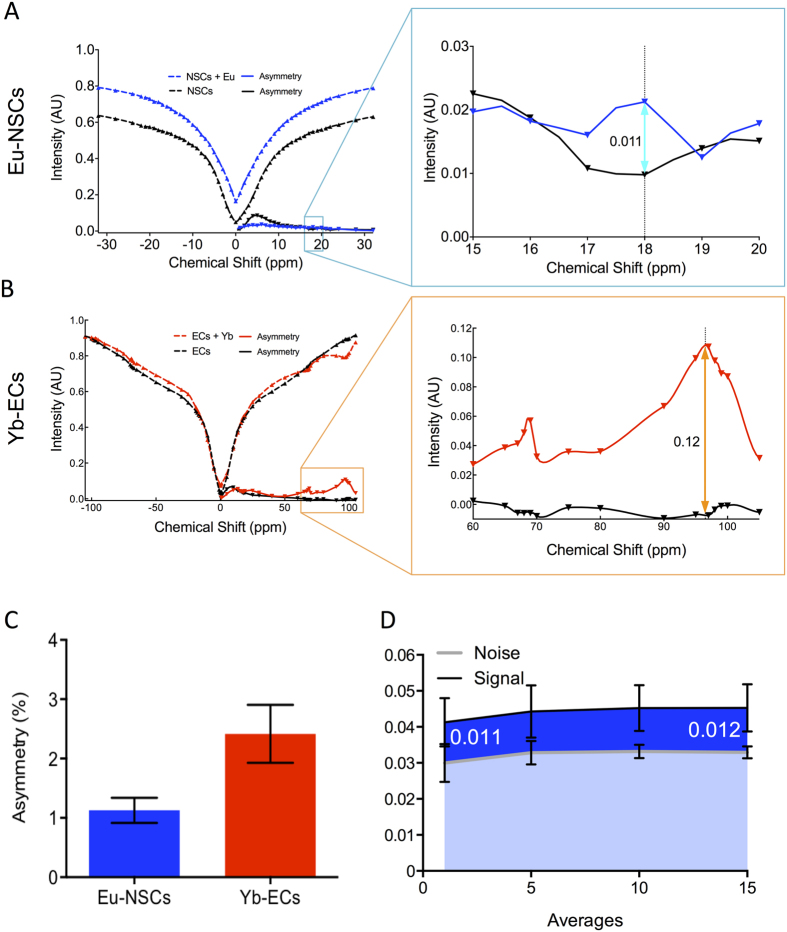
In vitro imaging of cell mixtures.(A) To determine if the required cell ratio will afford visualization, Eu-HPDO3A-labeled and unlabeled NSCs pellets were scanned in vitro to reveal a 1.1% difference in signal. (B) A 12% signal difference was evident between Yb-HPDO3A-labeled and unlabeled ECs. (C) At a cell mixture of 1 EC for every 4 NSCs, a signal asymmetry of 1.1% was maintained for Eu-labeled NSCs, but due to the lower abundance of Yb-HPDO3A-labelled ECs only a 2.3% effect was detected. (D) A 1.1% signal for Eu-HPDO3A-labelled cells was consistent, but a reliable distinction from noise required >5 signal averages.